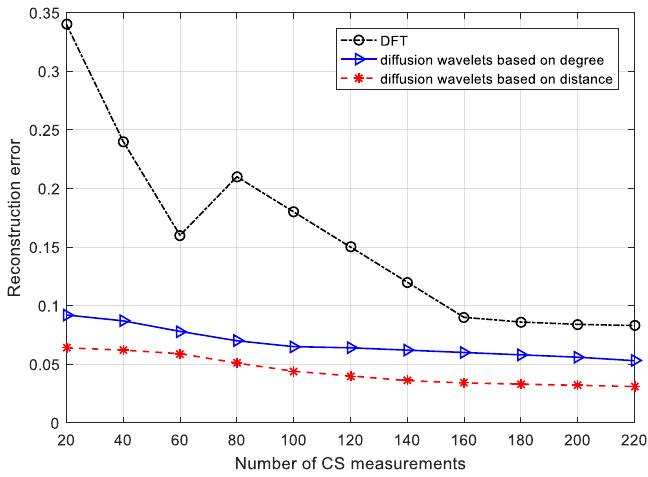
Figure 14. Reconstruction error vs. number of CS measurements.